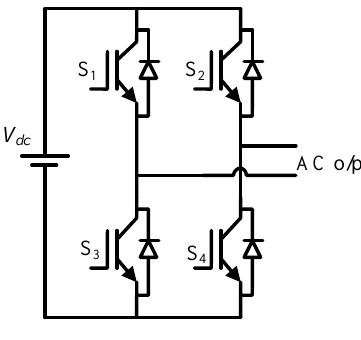
Figure 7. Voltage source inverter.